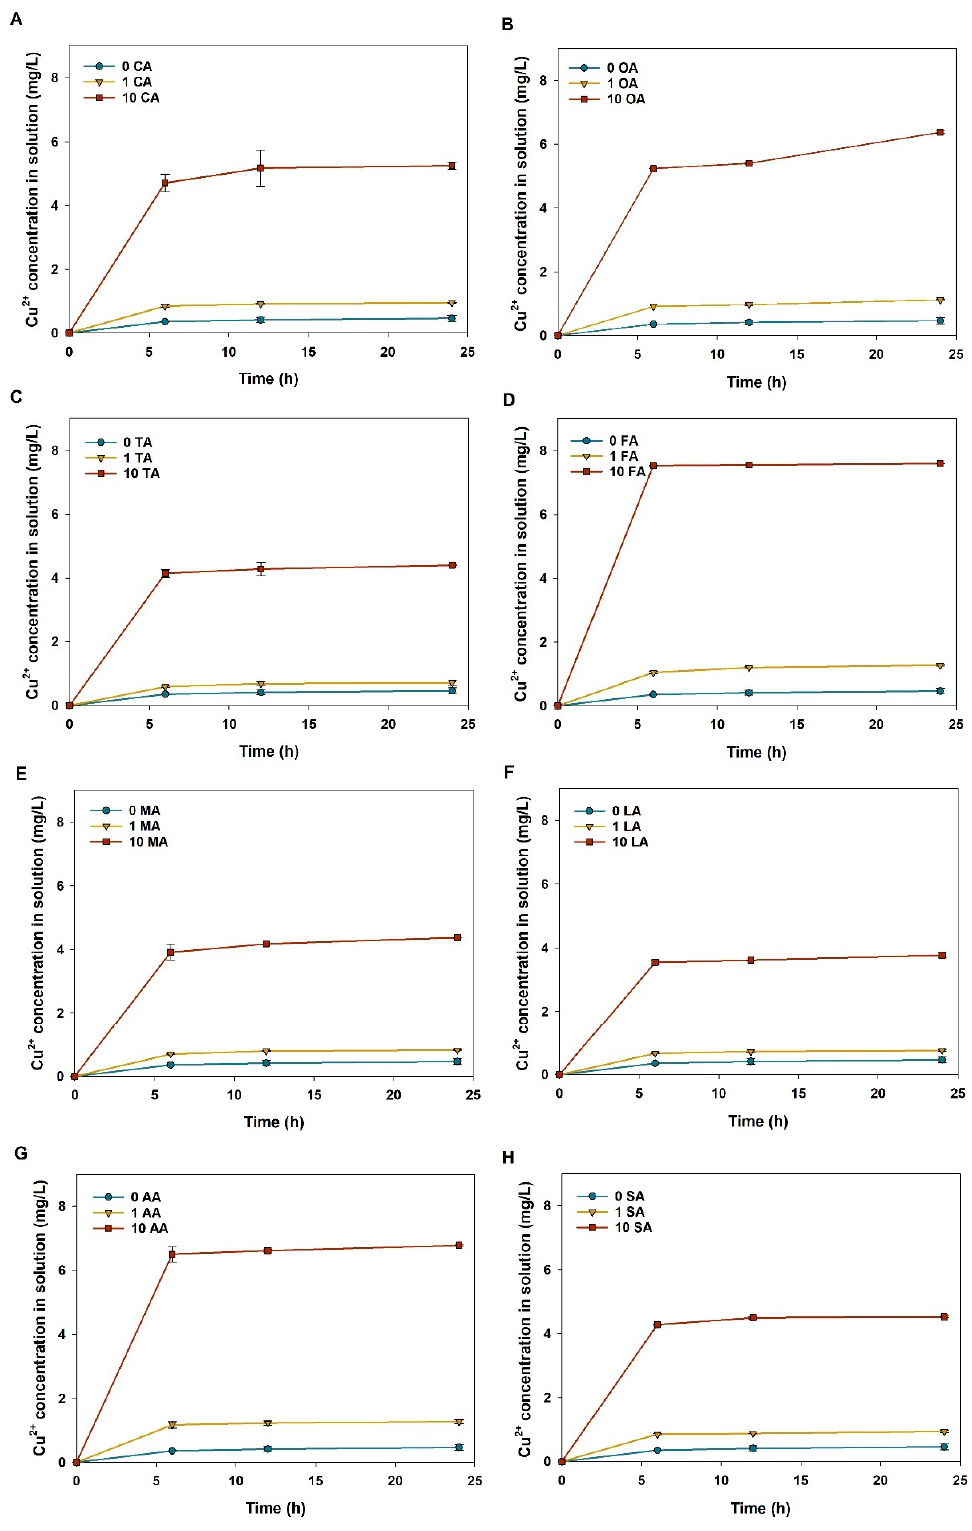
Figure 6. Dissolution of CuO NPs (100 mg/L) in aqueous solutions containing different LMWOAs. The values of Cu concentration are given as mean ± SD of triplicate samples. ( A ) CA: Citric acid; ( B ) OA: Oxalic acid; ( C ) TA: Tartaric acid; ( D ) FA: Formic acid; ( E ) MA: Malic acid; ( F ) LA: Lactic acid; ( G ) AA: Acetic acid; ( H ) SA: Succinic acid.